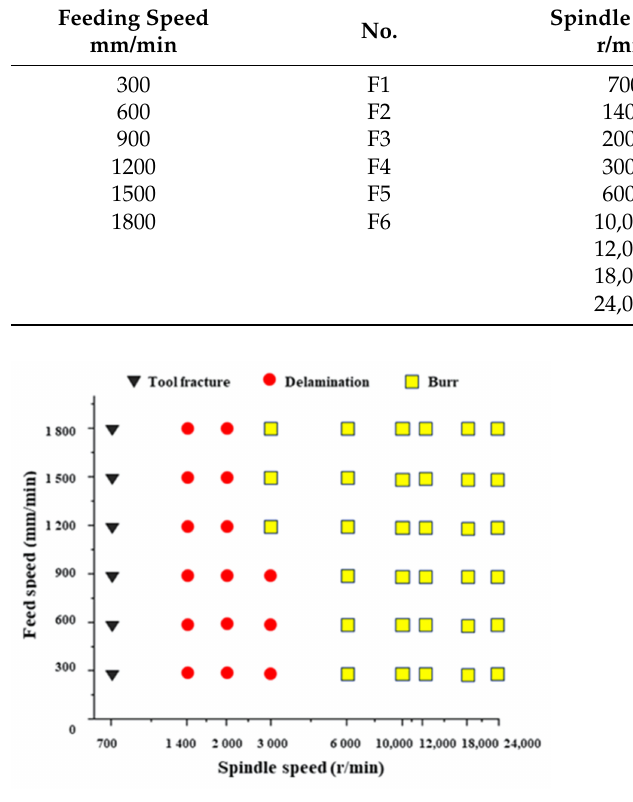
Figure 5. Influence of process parameters on milling property.